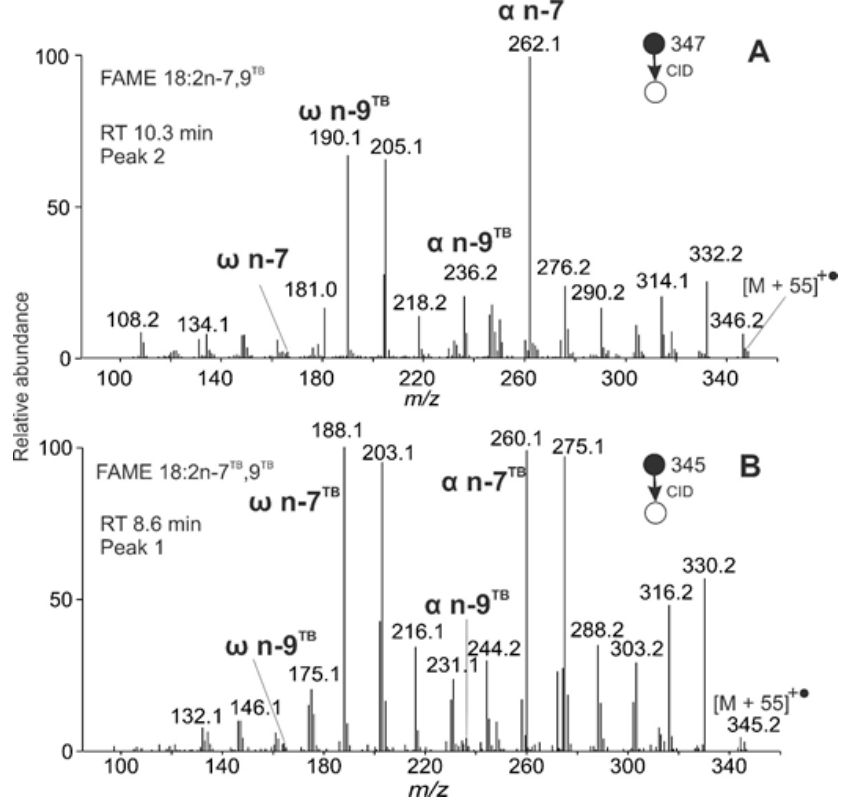
Figure 13. APCI MS/MS spectra of the [M + 55] +• adducts of acetylenic FAME from Santalum album